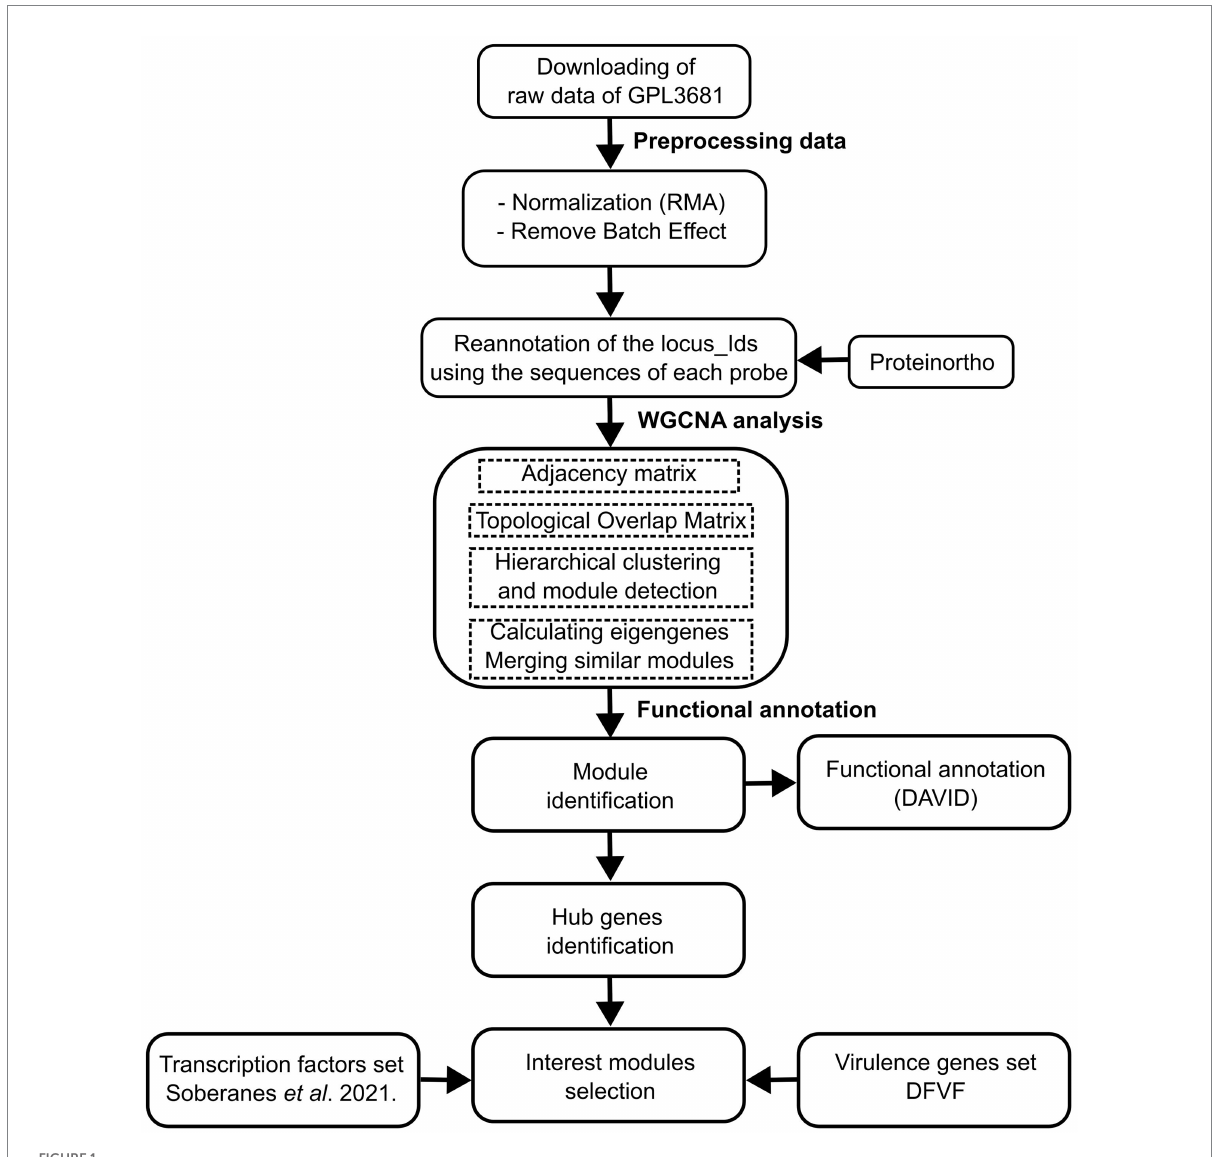
FIGURE 1 Schematic workflow of the data of preparation, processing, and